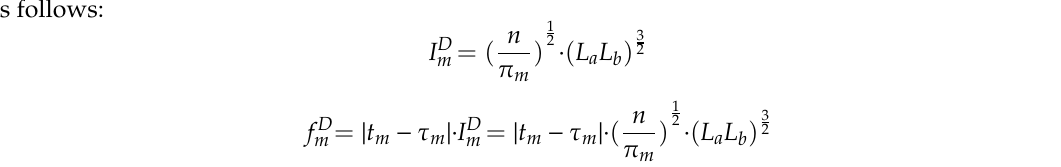
Figure 4. Characteristics of value changes of functions y = x 1 2 and y = x 3 2